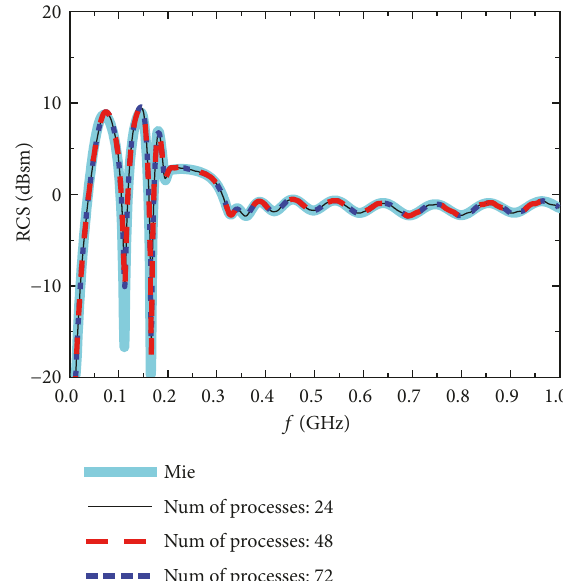
Figure 7: Parallel efficiency.